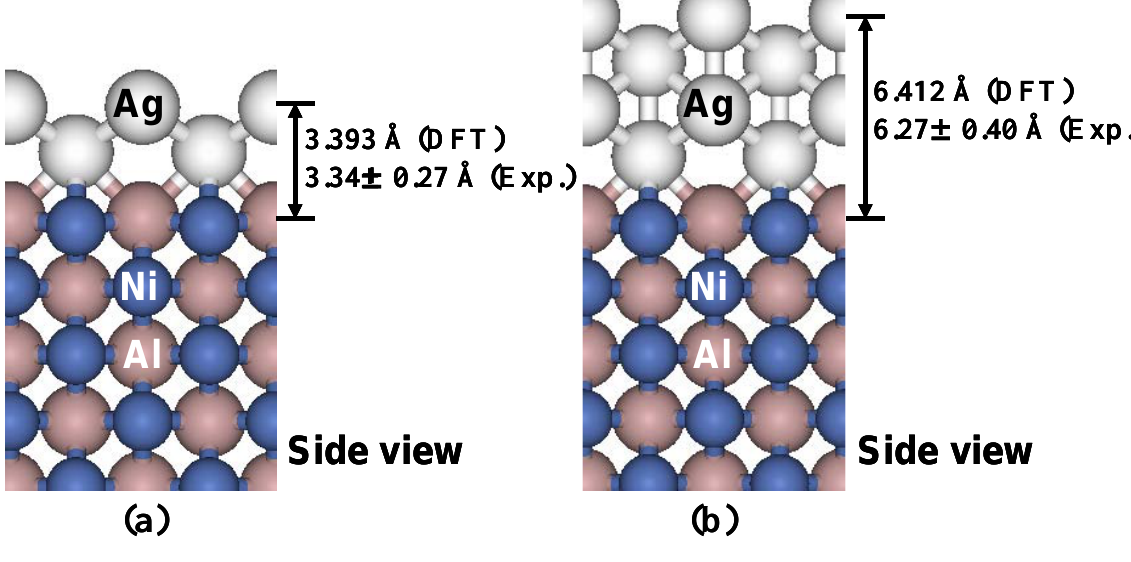
Figure 13. Relaxed structure (side view) of (a) 2 ML Ag(110) adlayer, and (b) 4 ML Ag(110) adlayer on a 11 ML NiAl(110) substrate as determined from the DFT calculations. The theoretical values (DFT) of the Ag(110) adlayer heights and the corresponding experimental values (Exp.) from line-profile analysis [46] are